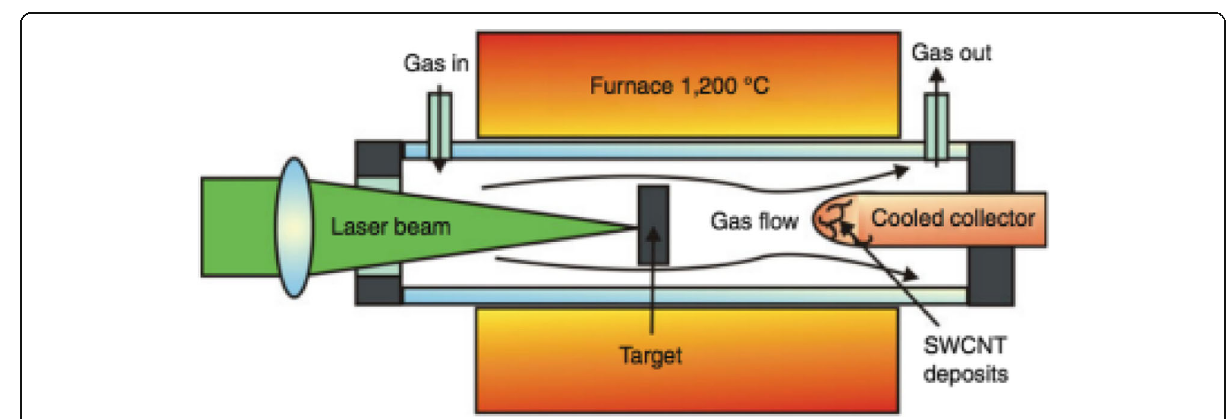
Fig. 6 Schematic diagram of a laser ablation system used to synthesize CNTs. In this technique, CNTs are produced in a quartz tube furnace with the help of a laser beam that vaporizes a graphite target leading to self-assembly of CNTs on the surface of the reactor. Based on the type of electrodes (pure graphite or graphite doped with Co, Fe or Ni), the formed CNTs can be single or multi-walled. Adapted from